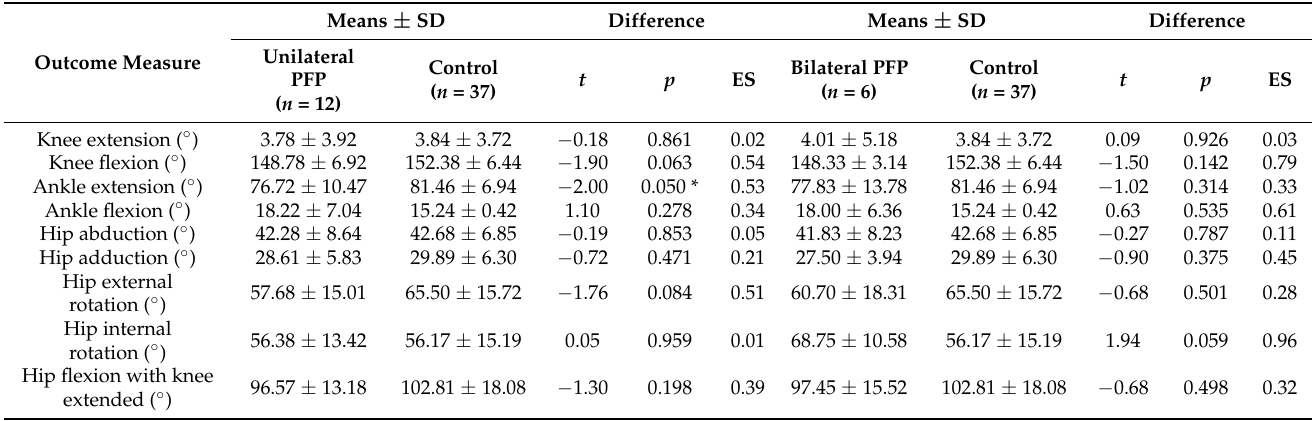
Table 5. Affected leg flexibility and stability outcome measures and between-group